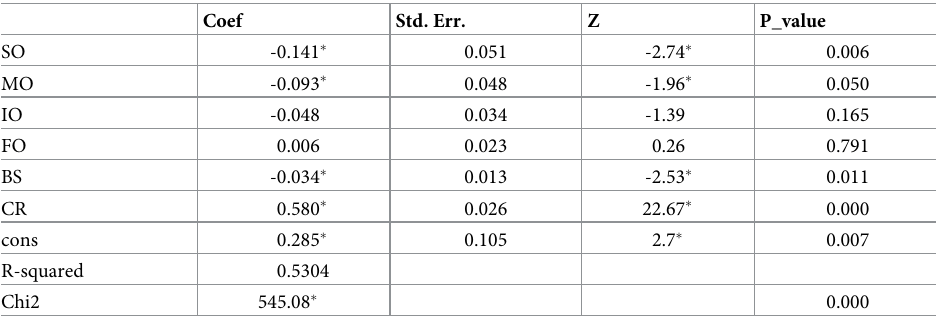
Dependent variable: NIM, � indicates statistical significance at 5%